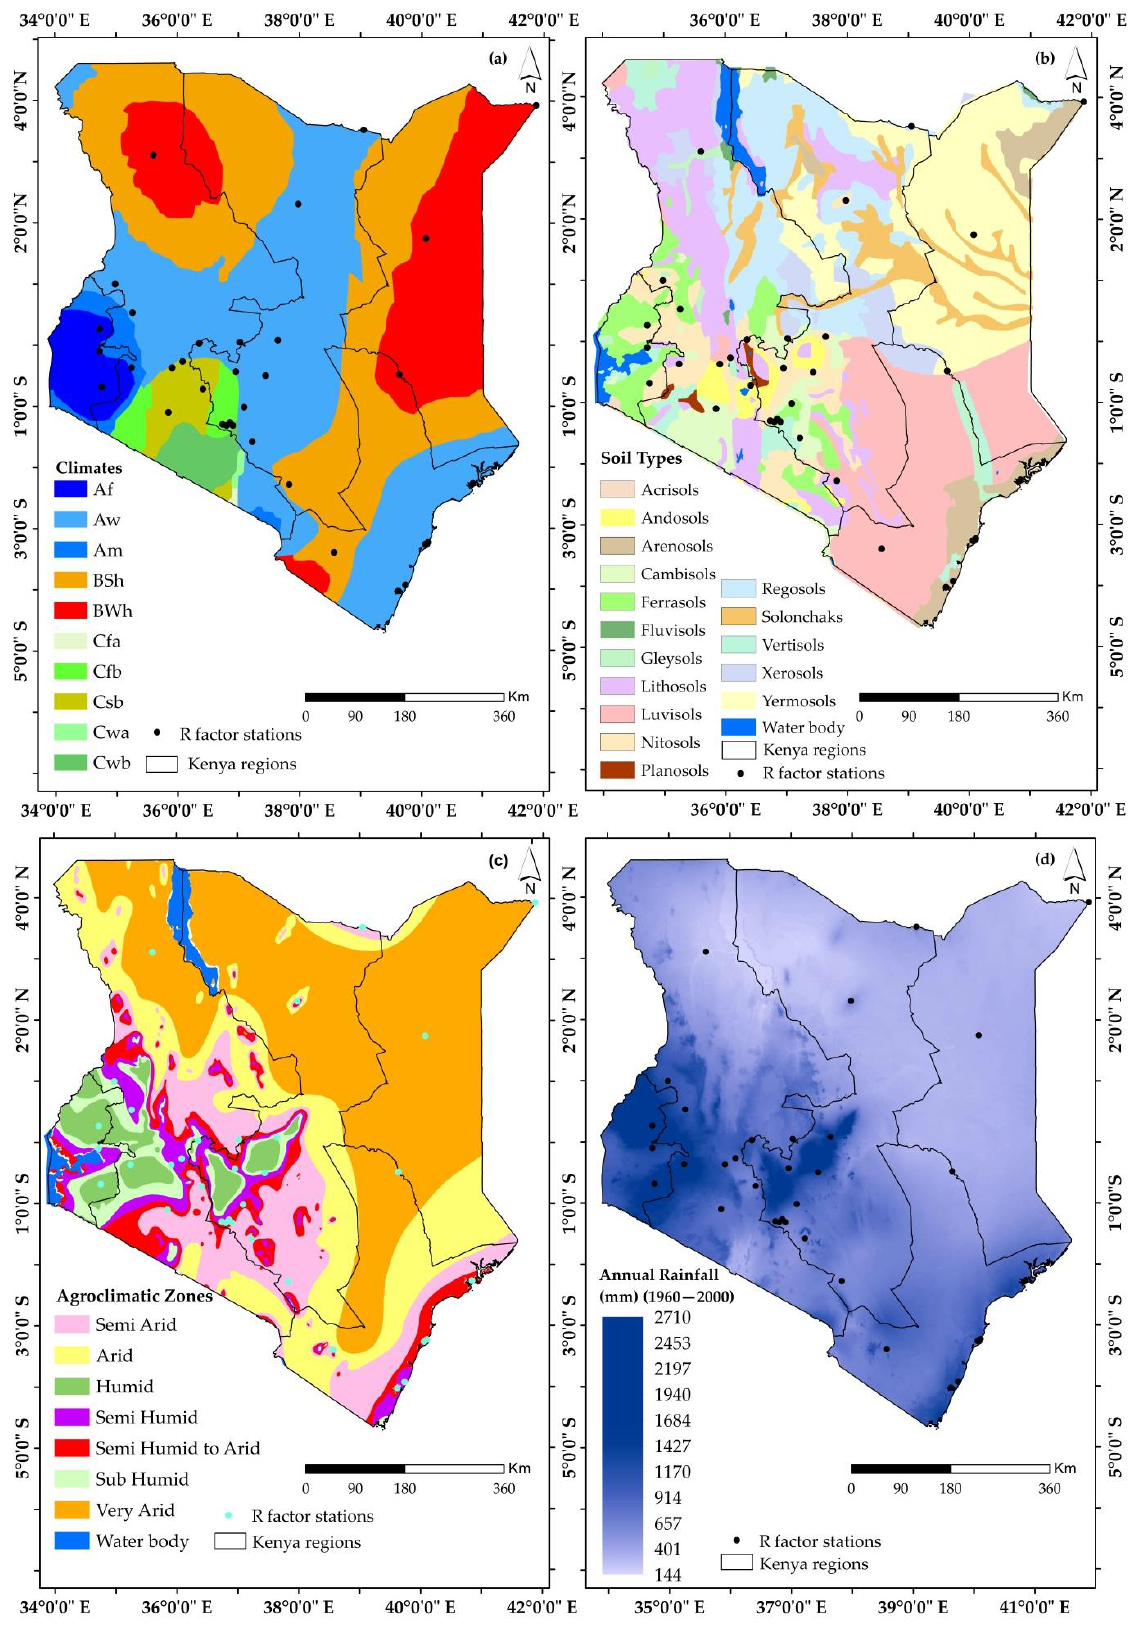
Figure 2. Characteristics maps of the study area: ( a ) Climate types; ( b ) Soil types; ( c ) Agroclimatic Zones; ( d ) Mean annual rainfall in Kenya.